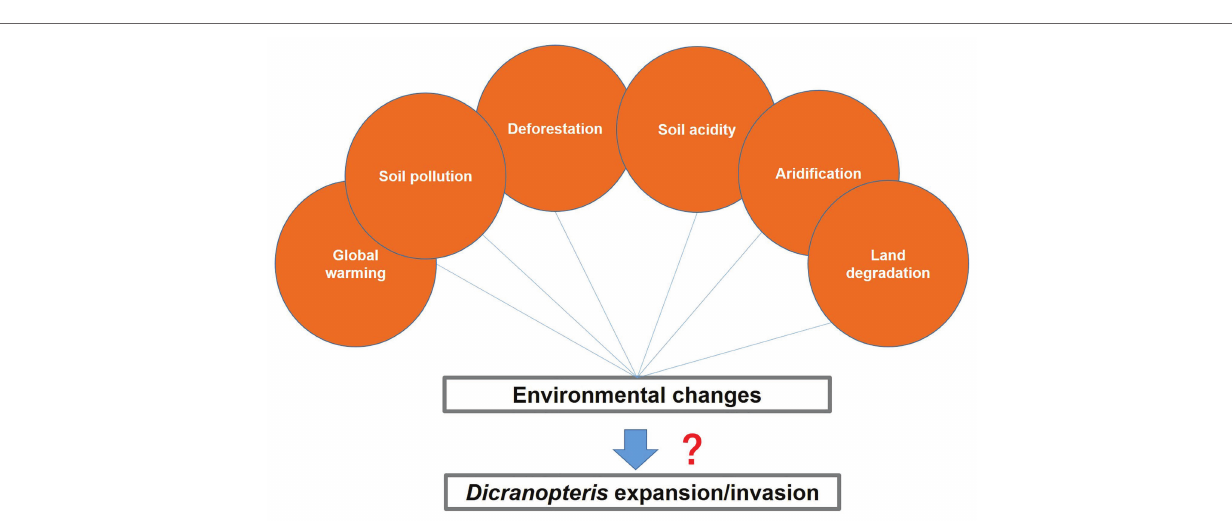
FIGURE 5 | Environmental changes that may lead to Dicranopteris expansion or